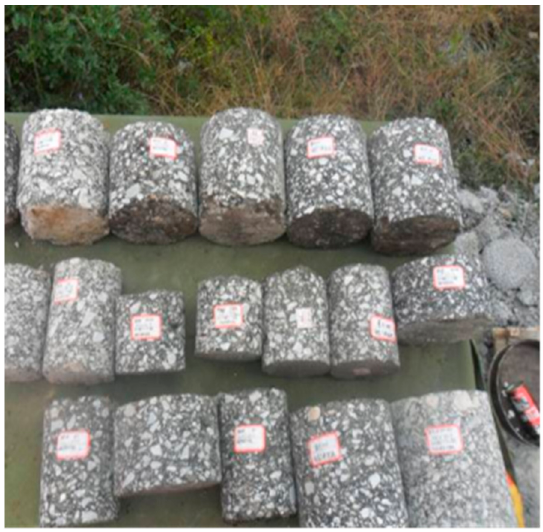
Figure 4. Samples of different CRM structure test sections.